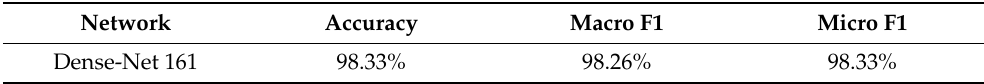
Figure 12. The loss curve and confusion matrix of multi-classification on INRIA and MSMT17 da- tasets: ( a ) The loss curve, ( b ) the confusion matrix. INRIA, ILIDS, and MSMT17 Datasets Results Table 17. The evaluation results on INRIA, ILIDS, and MSMT17 datasets. Table 17. The evaluation results on INRIA, ILIDS, and MSMT17 datasets.